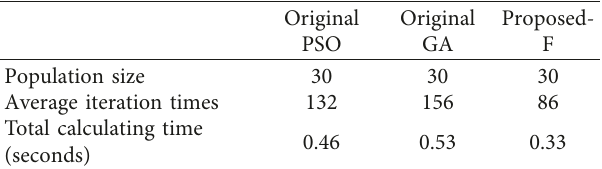
Table 4: Comparison of computational complexity of original GA, PSO, and the proposed fusion technique for SML estimation for the coherent